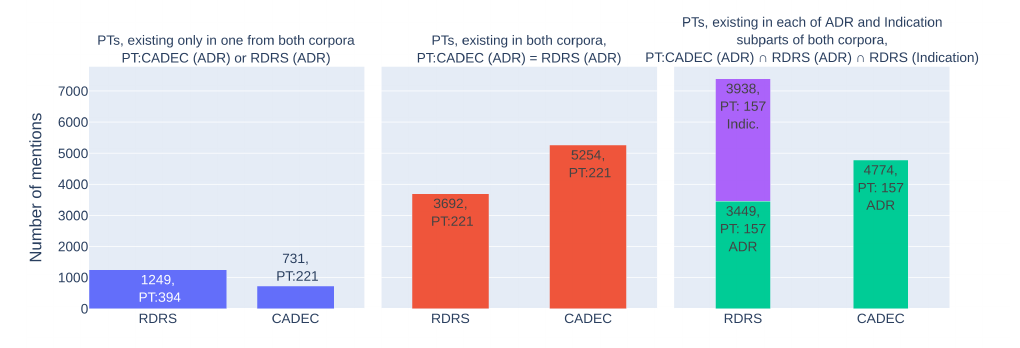
Figure 4. Similarities and differences between RDRS and CADEC